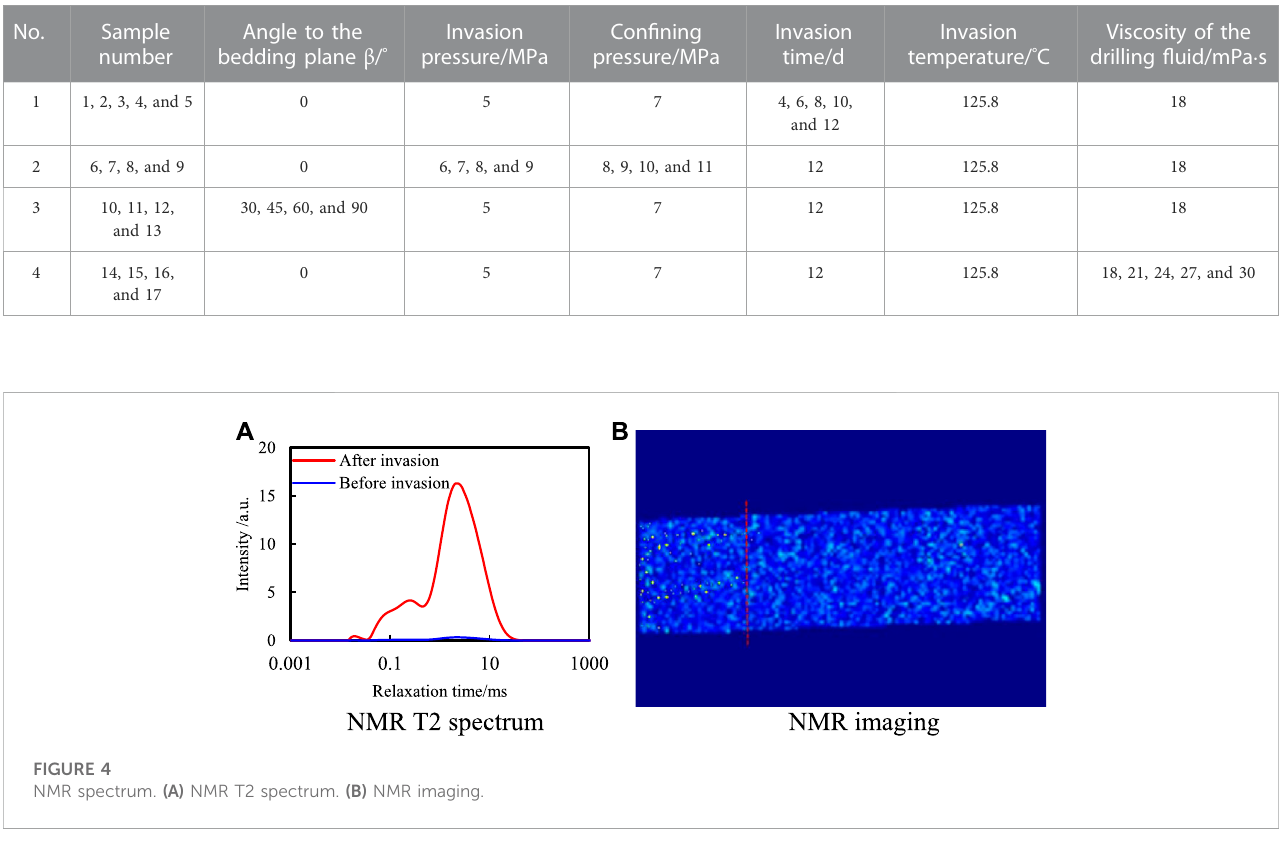
TABLE 1 Drilling fl uid invasion test conditions.